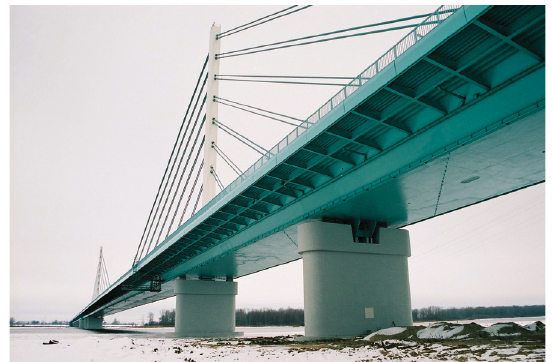
Figure 3. General view of the bridge